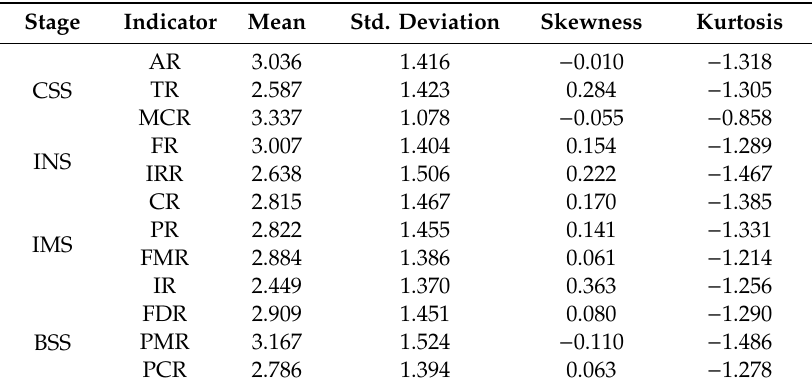
Table 3. Descriptive statistical results of the questionnaire.